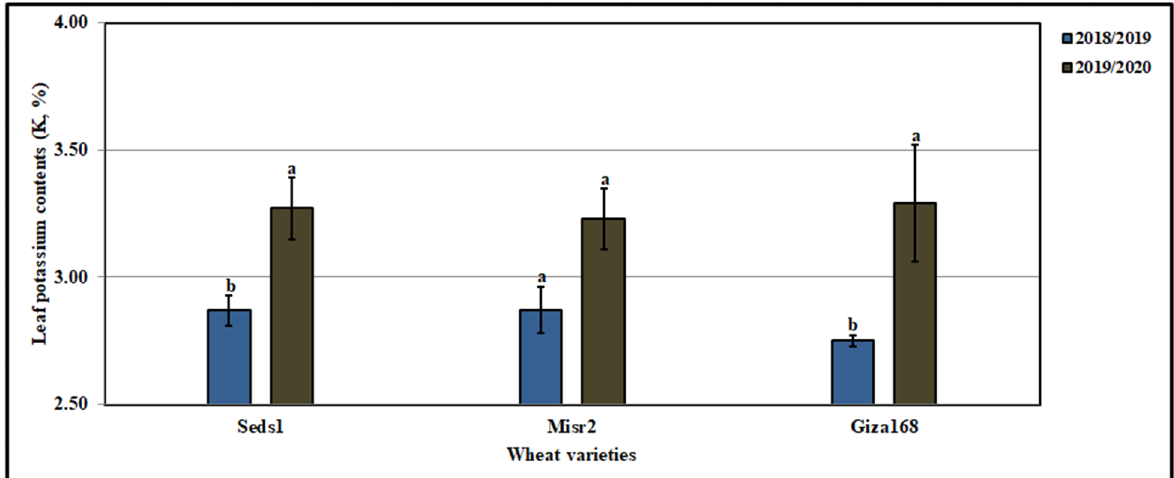
Figure 24. Influence of wheat varieties on leaf potassium contents (K, %) in clay loam soil in 2018/2019 and 2019/2020 seasons. Bars in the same years with a different letter indicate significant differences between treatments at p ≤ 0.01. HS 1, HS 2 , HS 3 represent HS applied as foliar spray at 1.0,